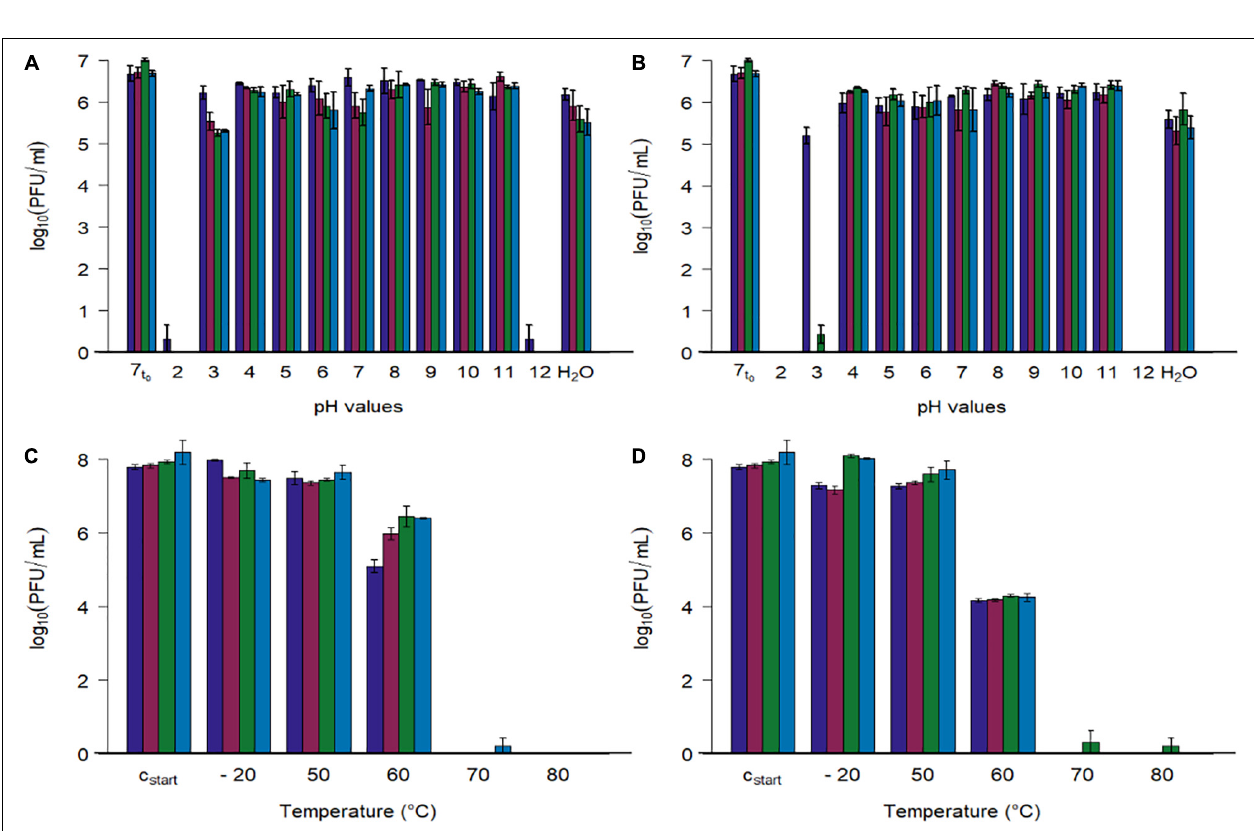
FIGURE 5 | Stability tests of four phages at different pH values and different temperatures. (A,B) Phage concentration after exposure to different pH values (2–12) and tab water (H 2 O) at two temperatures ( A : 22.3 ± 0.4 ◦ C, B : 41.7 ± 0.4). (C,D) Phage concentration after exposure to different temperatures (–20, 50, 60, 70, 80 ◦ C) at pH 7.4 ( C : 15 min, D : 60 min). Initial concentration of SM-buffered phage solutions was 10 8 plaque forming units/ml (c start ), which were diluted tenfold with pH adjusted phosphate buffer for the first experiment ( A,B , 7 t 0 = 1:10th dilution in pH 7 buffer at 0 h). Phage identity is represented as followes ( vB_CjM-LmqsCP1-4, vB_CjM-LmqsCP1-5, vB_CjM-LmqsCP74-2c1 and vB_CjM-LmqsCP132-3c). Columns represent the mean of the log 10 transformed concentrations; experiments were performed in triplicate and error bars indicate the standard error of the